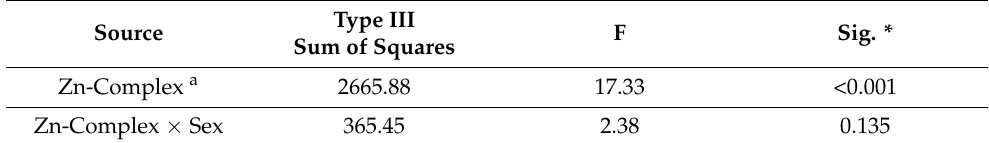
interaction. a Zn Complexes include ZnSO 4 , Zn-Glu, and Zn-Asp.